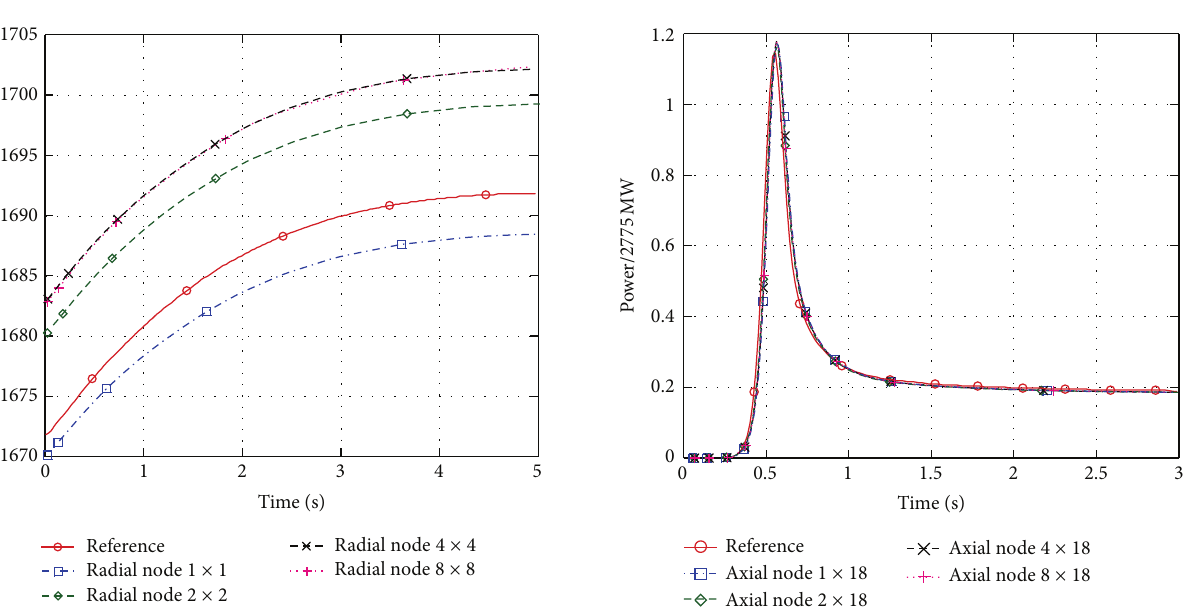
Figure 7: Effect of axial layer size on the power peak for case A1.